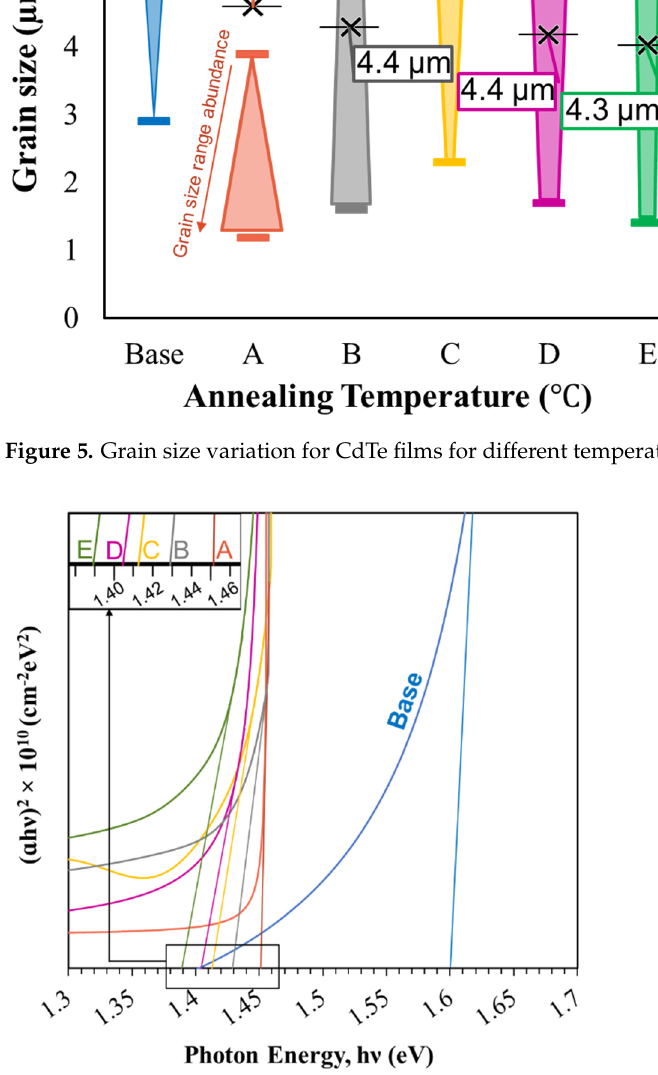
Figure 7. Tauc plot for the determination of bandgap of CdTe films before and after treatment. Table 4. Optical parameters of CdTe thin film for various annealing